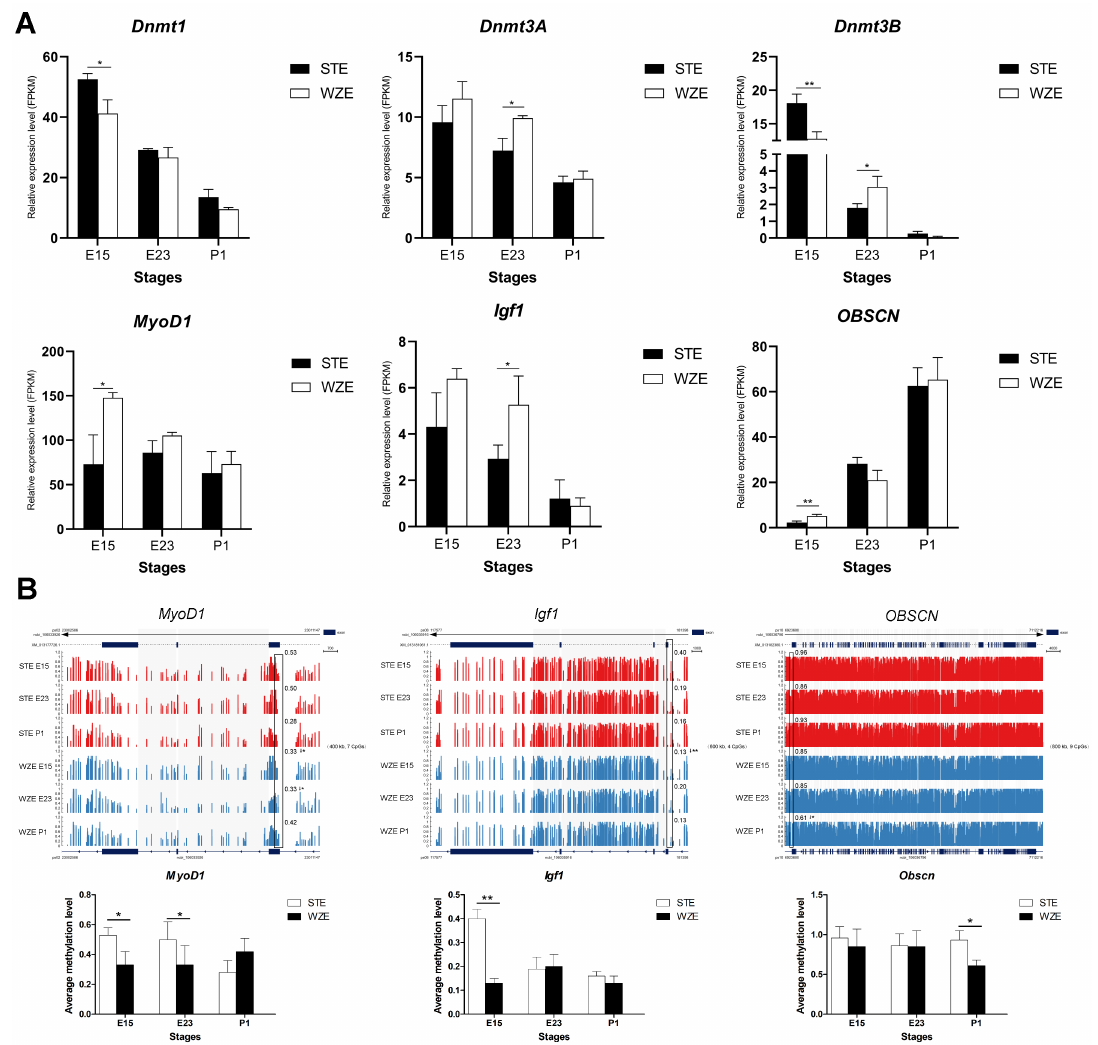
Figure 6. Gene expression patterns and DNA methylation level of vital DNA methylases and myogenic genes. ( A ) RNA-seq gene expression pattern of crucial DNA methylases and myogenic genes in STE and WZE during E15–P1 ( n = 3). ( B ) DNA methylation level of myogenesis-related DEGs related to DNA methylation or vital myogenic genes in WGBS data illustrated by IGV software in STE and WZE during E15–P1. Regions around TSSs are marked in black boxes with average DNA methylation level shown beside the boxes. The length of and the number of CpGs in this box is marked in the figure. Quantitative analyses of indicated boxes are presented. Downward arrows indicate a lower DNA methylation level in comparison with STE. * p < 0.05; ** p <